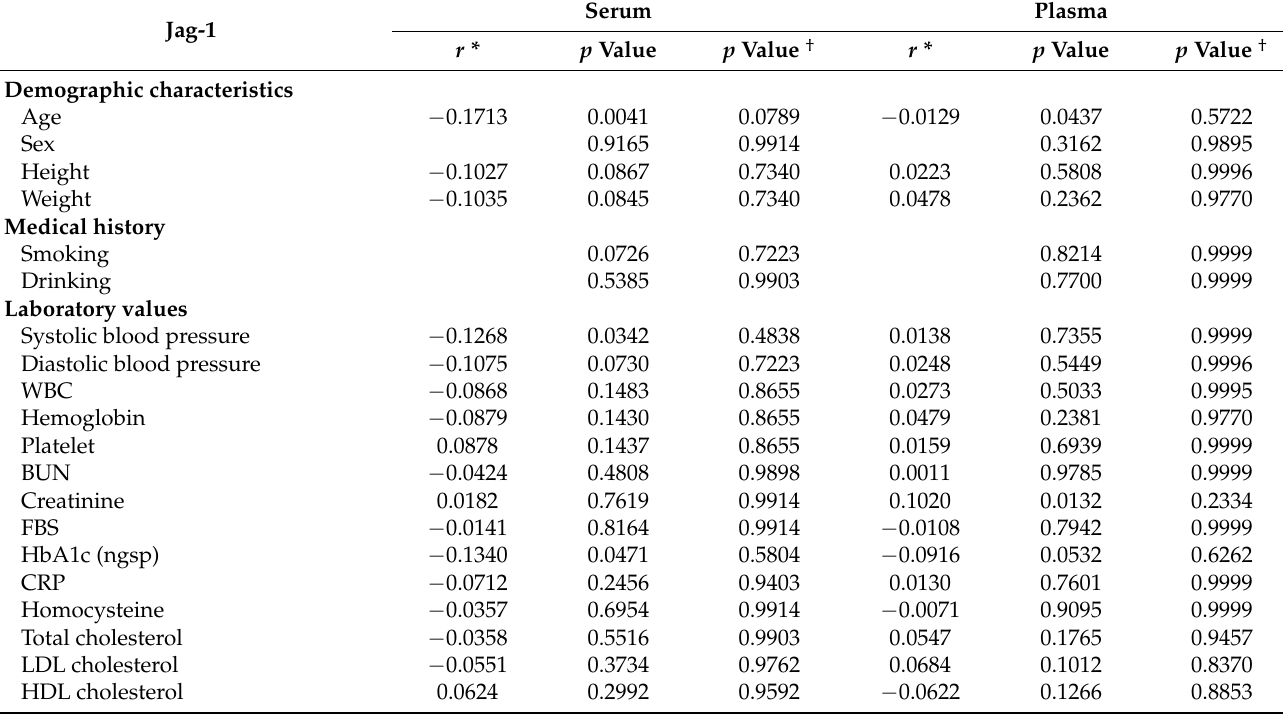
Table 3. Correlations between blood Jag-1 levels and clinical